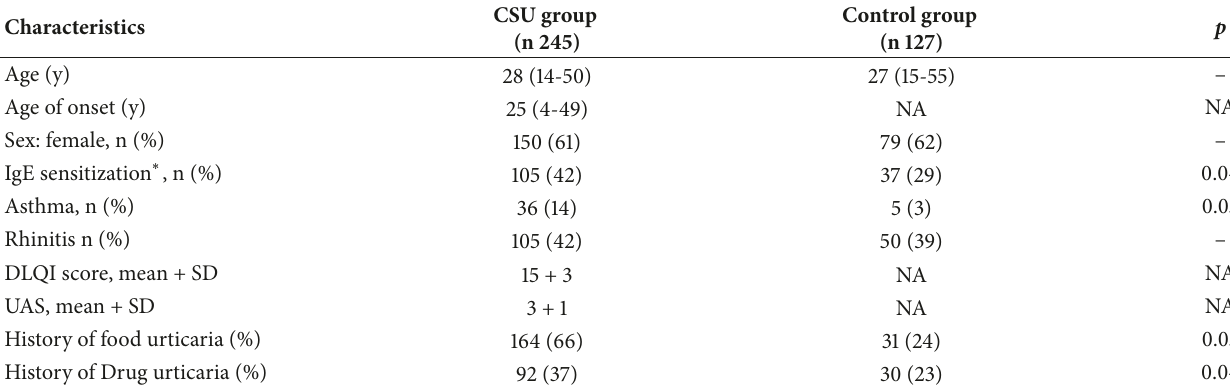
Table 1: Population characteristics.